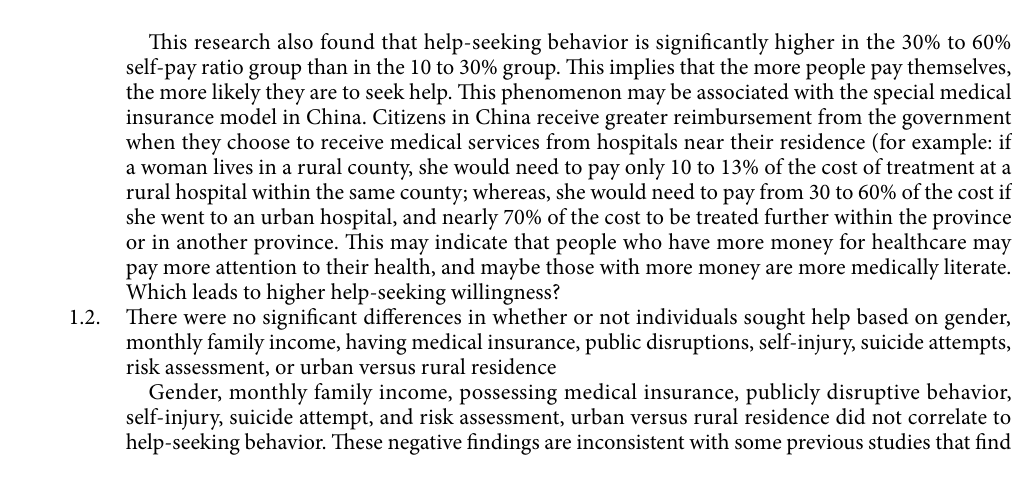
Figure 1. Reasons for non-help seeking